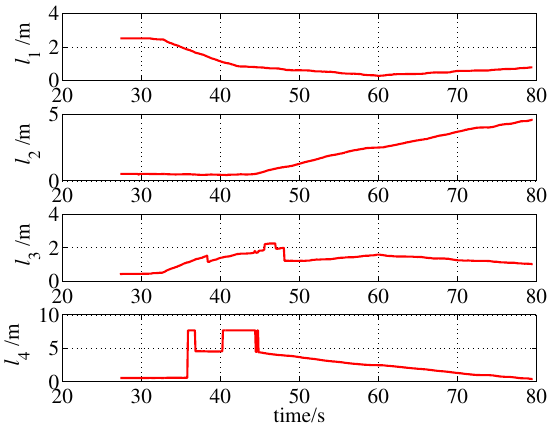
Figure 21. Sonar measurements (without unmodeled obstacles).